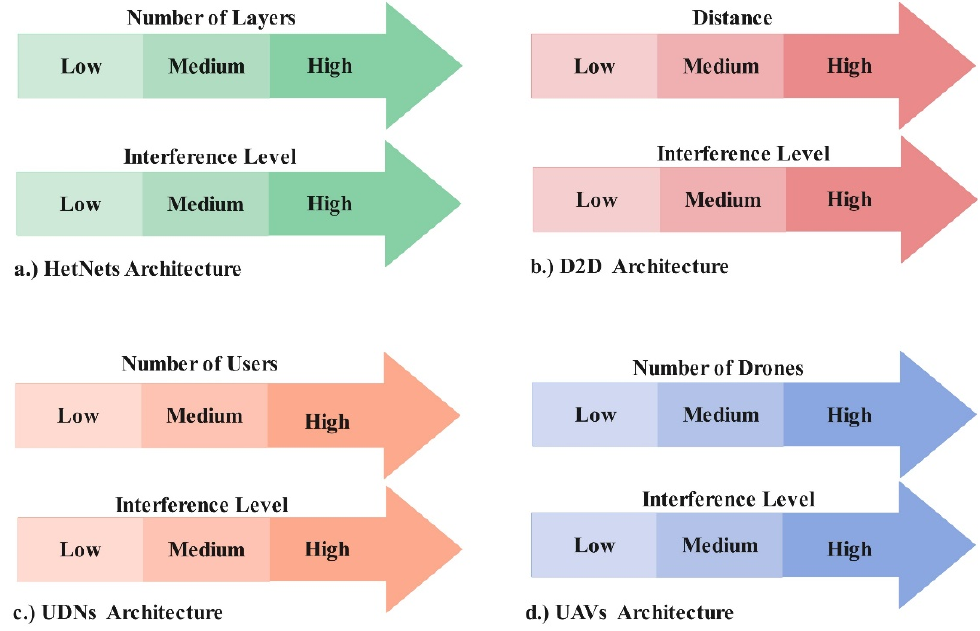
Figure 16. The relationship between interference level and critical parameters with respect to different architecture networks.